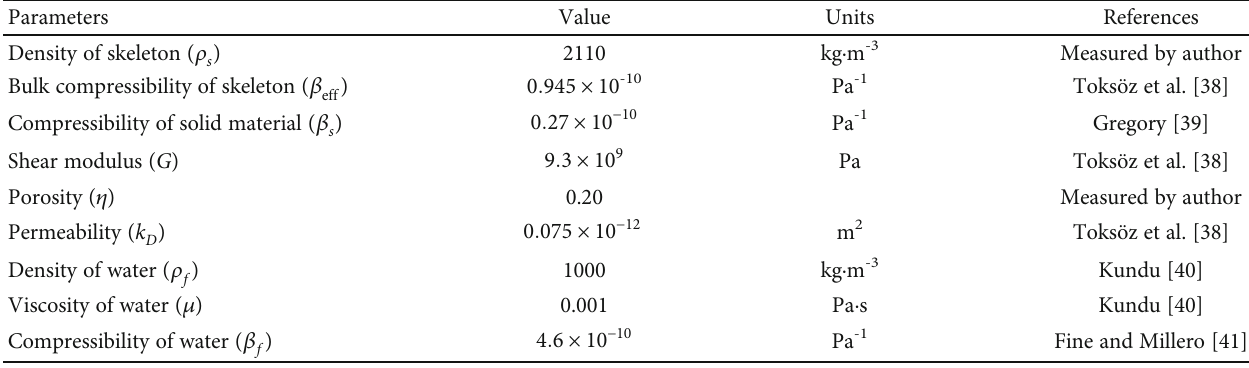
Table 1: Measured parameters of Berea sandstone and water.